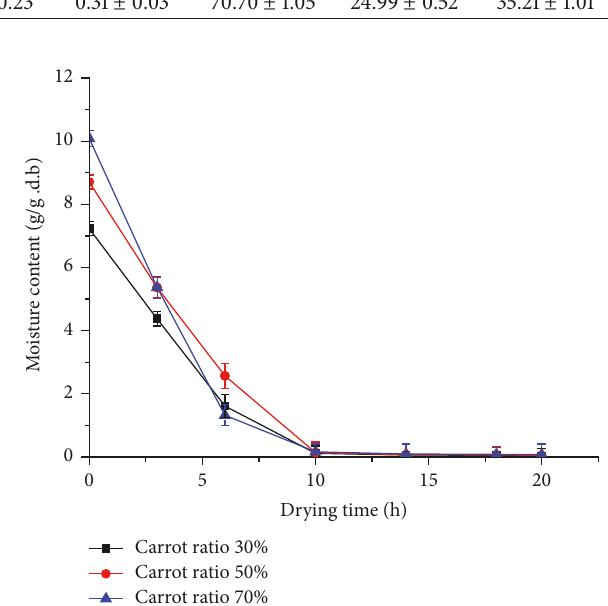
Figure 1: Freeze-drying curves of the restructured carrot-potato